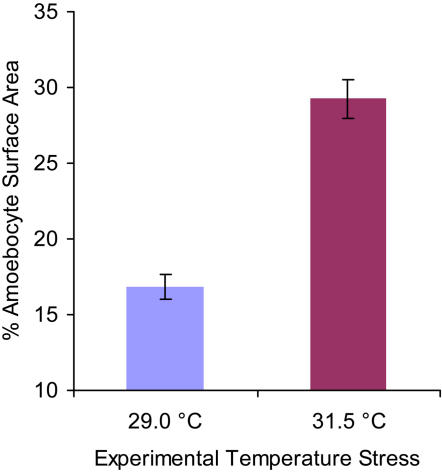
Increase in amoebocyte surface area in sea fans exposed to elevated temperature (31.5°C) for 8 days.Data presented are mean±s.e.m, n = 6, X
2 = 305.11, p<0.0001.